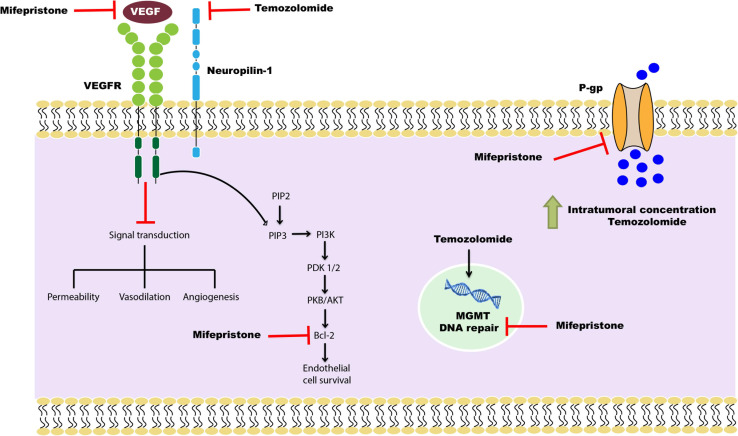
Schematic portrayal of the possible mechanisms of the combination mifepristone/temozolomide treatment that improved the effect found with temozolomide alone. The mechanisms studied were: (1) the inhibition of angiogenesis, measured as reduced levels of VEGF; (2) the attenuation of DNA repair, evaluated as a decrease in MGMT; and (3) the increased capacity of temozolomide to pass through the BBB, assessed as a lower P-gp level and a higher concentration of temozolomide in brain cells. As described in a previous report by our group (5), mifepristone diminishes the level of anti-apoptotic protein Bcl-2 and impedes endothelial cell survival in tumors. This may be the mechanism by which mifepristone/temozolomide herein lowered the level of VEGF. The treatment with mifepristone or temozolomide alone decreased the levels of VEGF to a lesser extent, perhaps by the blockade of autocrine VEGF signaling through specific down-regulation of NRP-1. Additionally, a decline in the expression P-gp was found when administering mifepristone/temozolomide. Thus, this combination treatment may allow for an enhanced intratumoral concentration of temozolomide and contribute to greater tumor cell death. The latter was evidenced by lower tumor proliferation during the drug treatment period. As can be appreciated, mifepristone appears to sensitize glioblastoma cells to the effects of temozolomide.